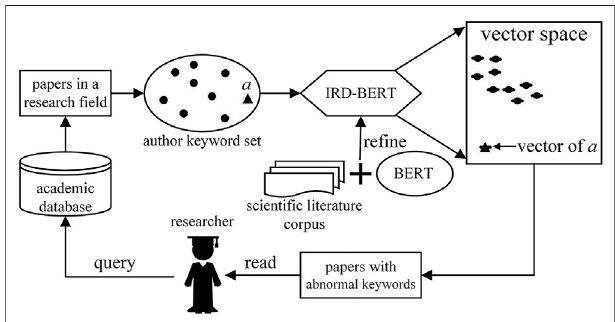
FIGURE 2 | Discovering interdisciplinary research using